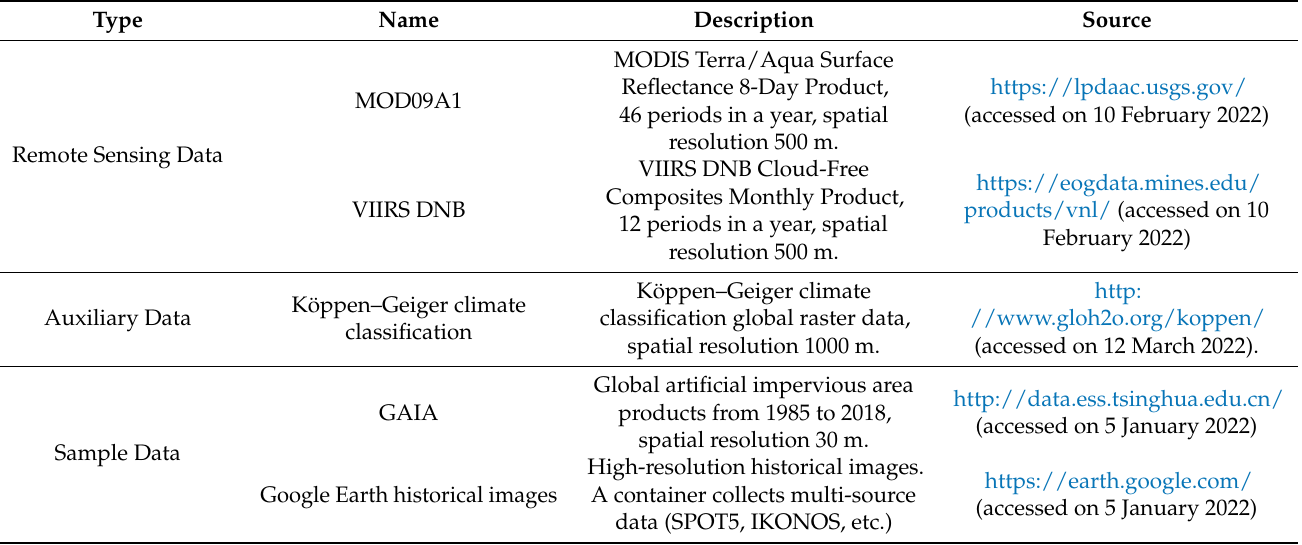
Table 1. The details of data used in this